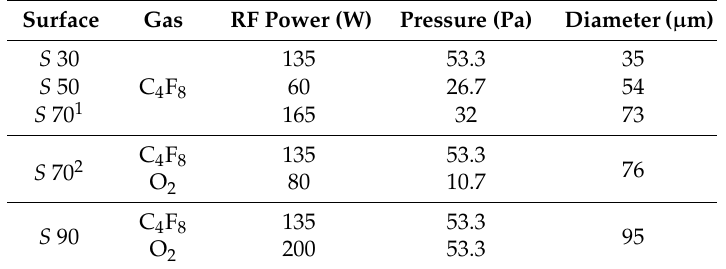
Table 1. Plasma treatment conditions for various droplet diameters on the glass substrate.